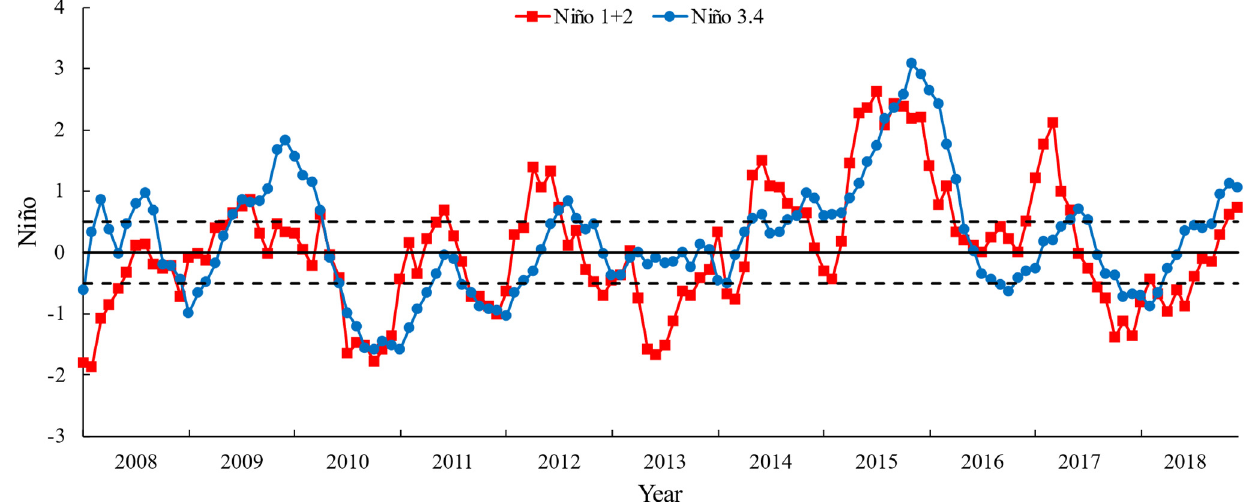
Figure 2. The time series of Niño 3.4 (between 5° N and 5° S and 120° and 170° W) index and Niño 1 + 2 (between 0° and 10° S and 90° and 80° W) index from 2008 to 2018. Dashed lines of ± 0.5 are the definition of the El Niño/La Niña event: the NI over 0.5 represents the El Niño event and below − 0.5 represents the La Niña event.